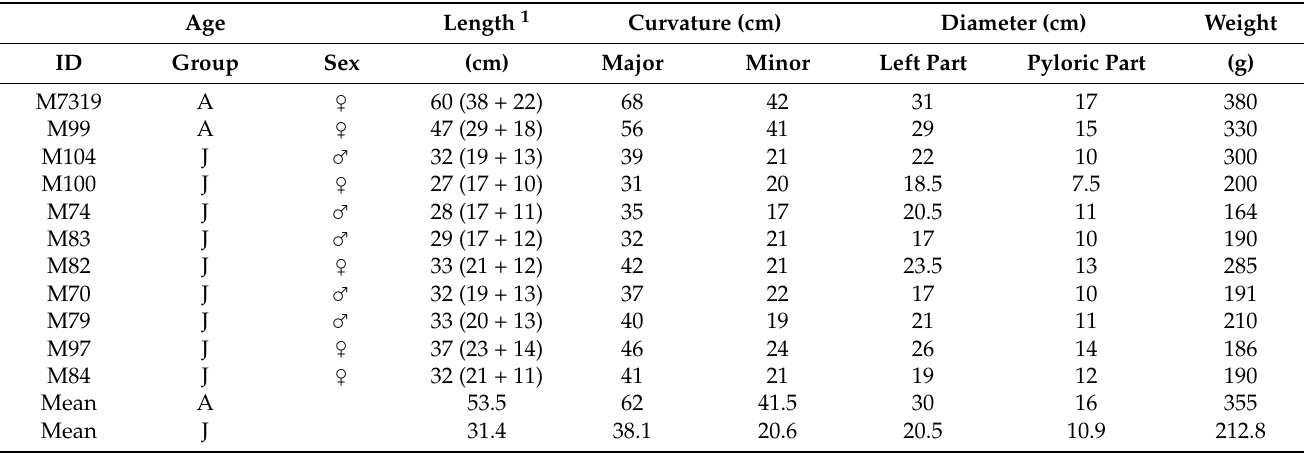
Table 3. Morphometric data of the stomach proceeding of the 11 specimens of Arctocephalus australis used in the present study. A: adult; J: